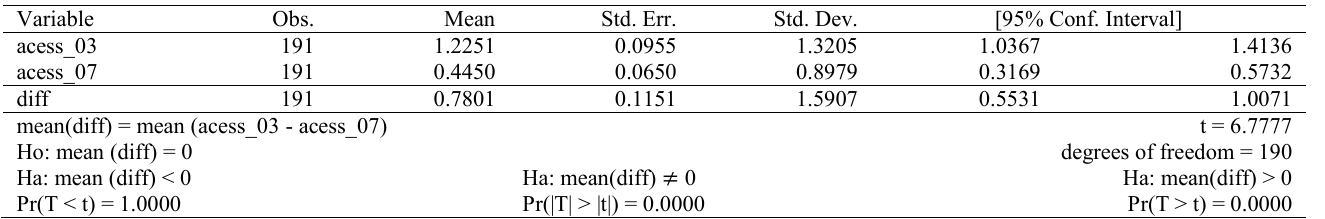
Table 7: Mean-comparison test (paired) for access to finance: 2003 vs. 2007 Variable